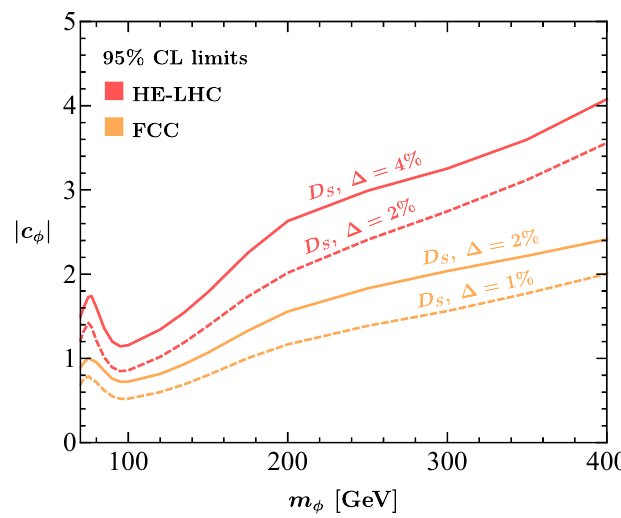
Figure 5 . 95% CL limits on | c φ | as a function of m φ derived from the binned-likelihood analysis of the ME-based kinematic discriminant D S . The red and orange exclusions illustrate our HE-LHC and FCC projections, respectively. The systematic uncertainties that have been assumed to obtain the different bounds are shown next to the lines and vary between ∆ = 4% and ∆ = 1% . Further details are given in the main